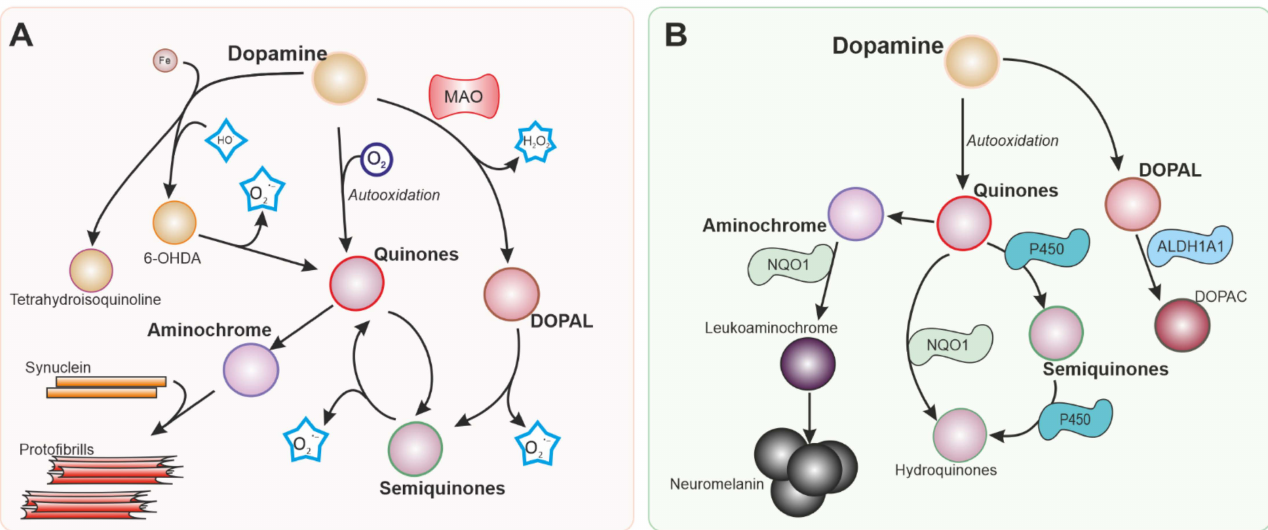
Figure 1. Intracellular dopamine metabolism. Parkinson’s disease is characterized by the degeneration of dopaminergic neurons in the substantia nigra. Dopamine metabolism is responsible in part for the vulnerability of the neurons in this nucleus. Reactions generating reactive oxygen species (ROS) from dopamine and its metabolites are shown in ( A ). Nrf-2 regulates several enzymes represented in ( B ) involved in detoxifying reactions that can mitigate the production of ROS and metabolites that are toxic for dopaminergic neurons. MAO: Monoamine oxidase. 6-OHDA: 6-hydroxydopamine.